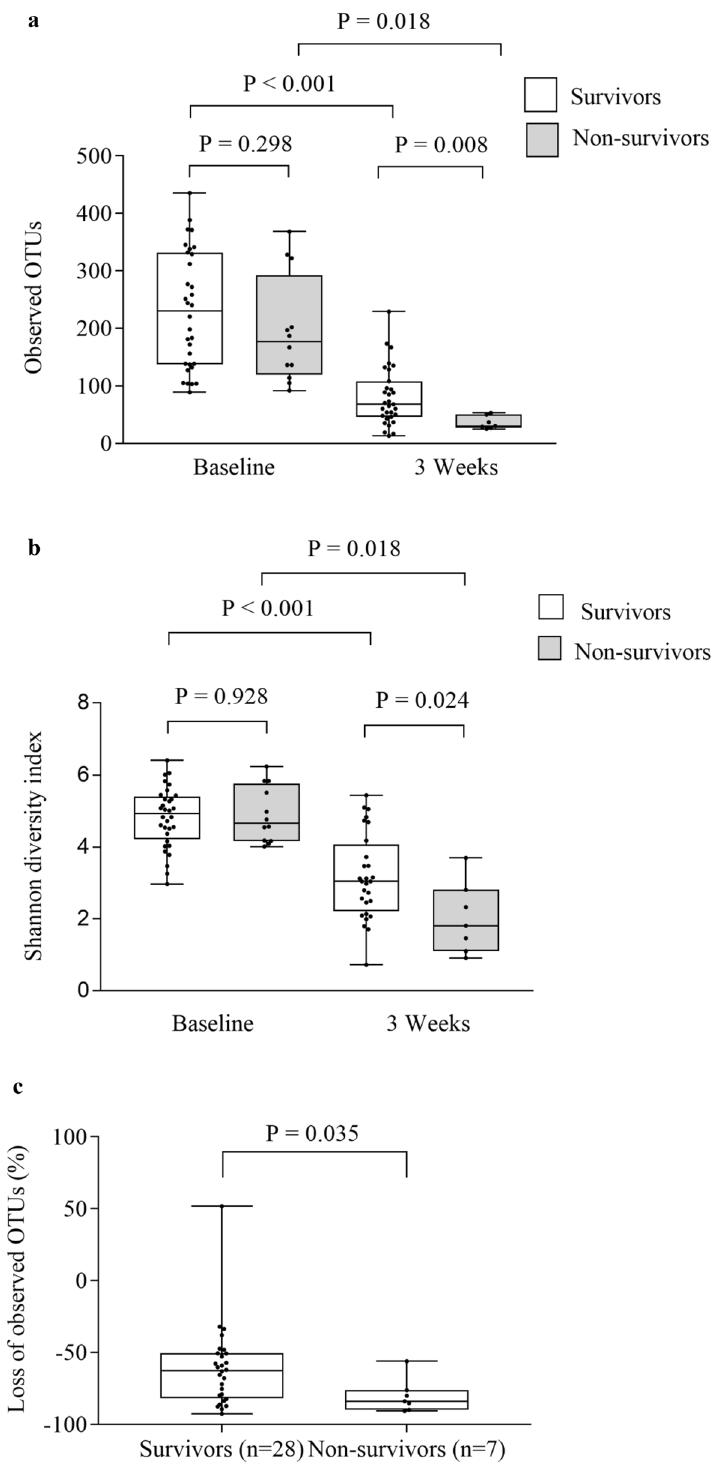
Figure 4. Gut microbiota diversity and one-year survival. ( a ) Observed operational taxonomic units (OTUs) at baseline and 3 weeks and one-year survival, ( b ) Shannon diversity index at baseline and 3 weeks and one-year survival, ( c ) Loss of observed OTUs from baseline to 3 weeks and one-year survival. Data are observed OTUs and Shannon diversity index, and given as individual values (dots) and box plots (median and interquartile range) with minimum and maximum